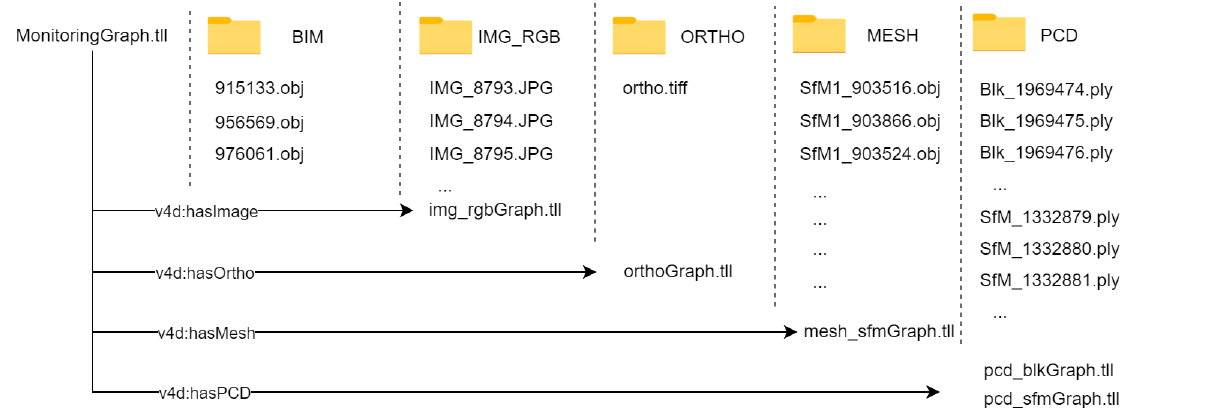
Figure 4: Overview of the monitoring data structure and RDF graphs generated by week 22 remote sensing data and as-design